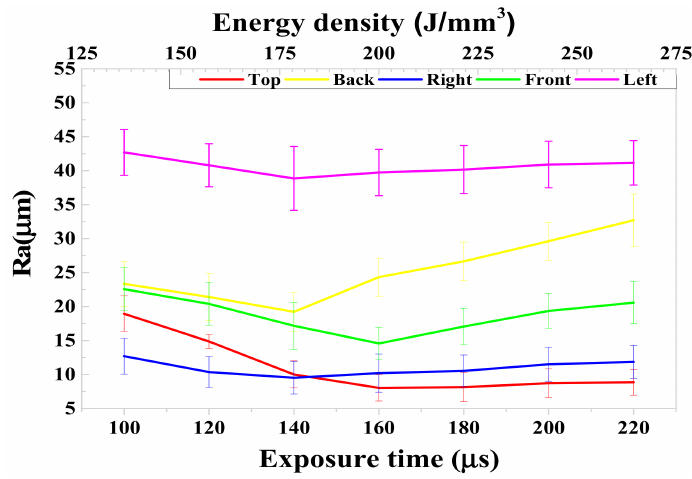
Figure 4. The roughness with different exposure